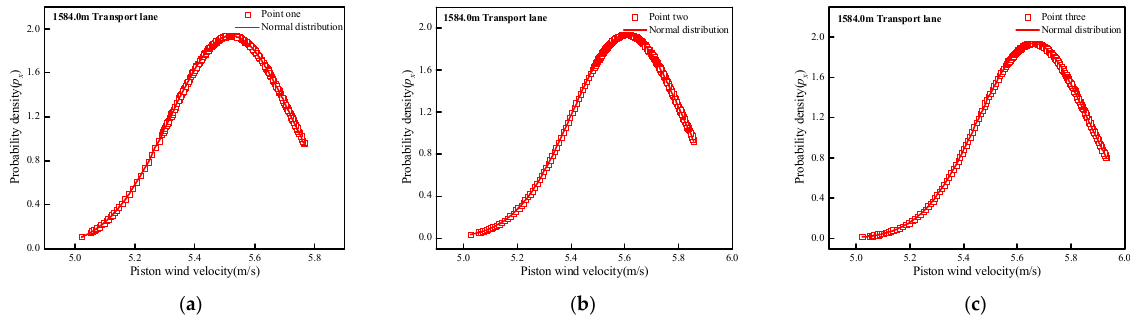
Figure 14. Probability density of characteristic points of 1765.0 m transport lane: ( a ) Point one, ( b ) Point two, ( c ) Point three.